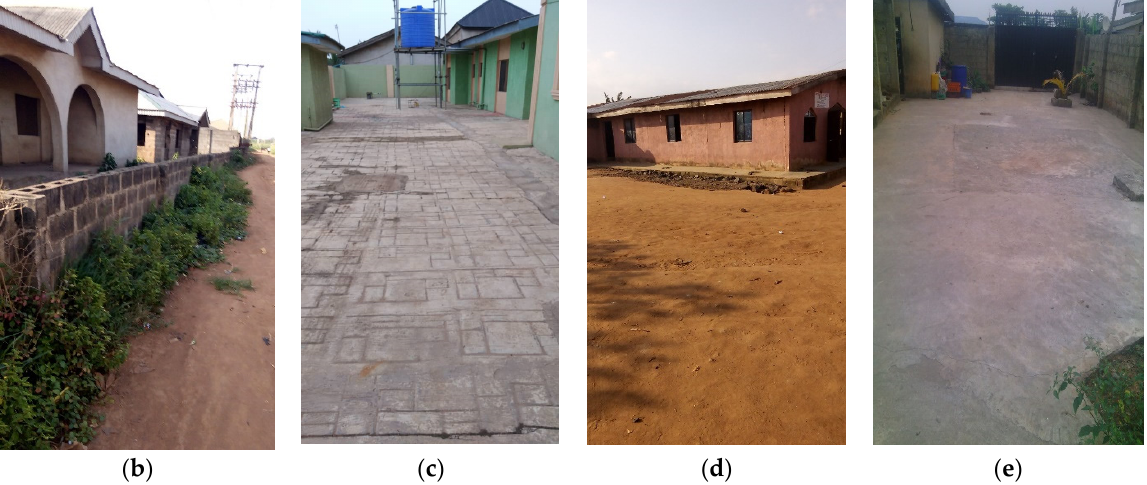
Figure 1. ( a ) Location of the four study areas on a Google map (source: Google Earth, 2020). ( b – e ) Surroundings of Areas 1–4, respectively.